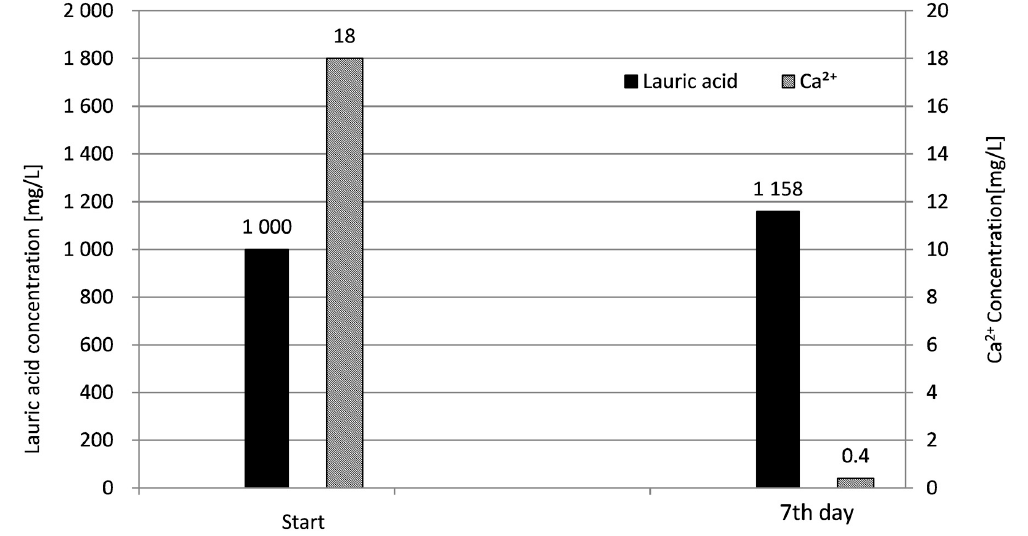
Figure 9. Comparison of water quality analysis in Case L during different periods.